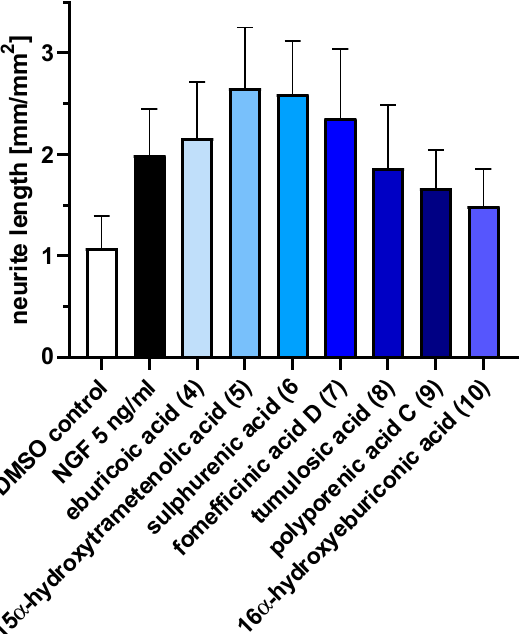
Figure 5. Graph showing the mean neurite length of PC-12 cells treated with different triterpenes sup- plemented with 5 ng/mL ngf after 72 h ± S.E.M. Data originate from three independent